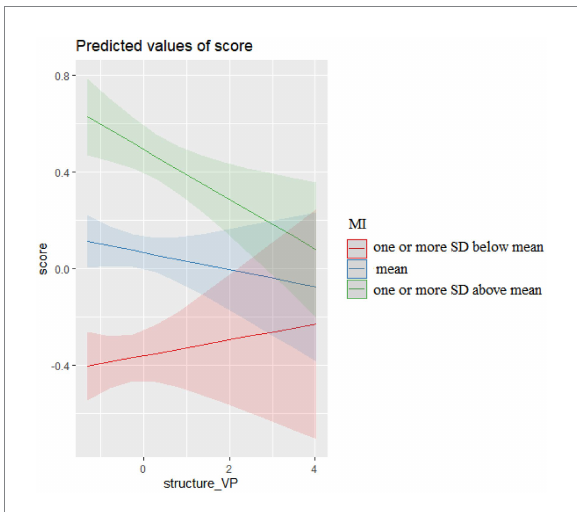
FIGURE 2 The interaction effects of VP sequences and MI on scores.